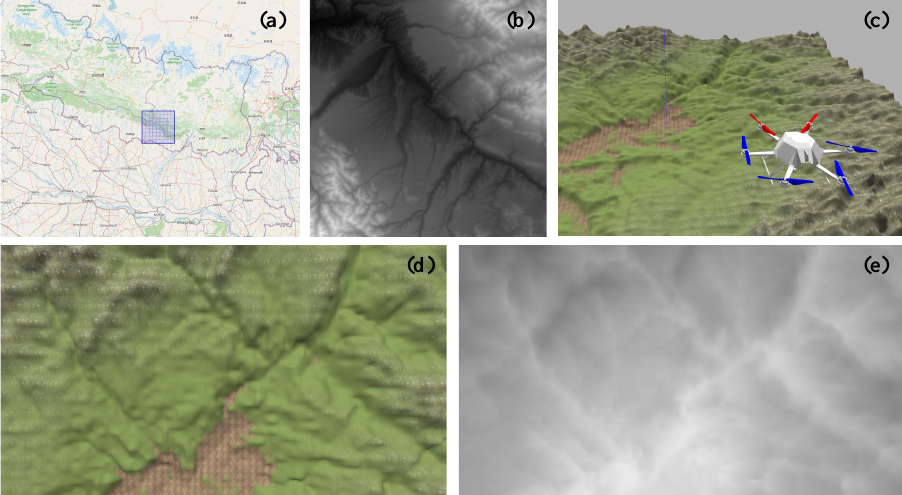
Figure 8. Selected area ( a ) is located in the middle part of the Himalayan, ( b ) is its corresponding depth maps generated by terrain.party. ( c ) shows the s UAV, which is equipped with an RGB-D camera for RGB video capture and depth ground truth data collection. The depth sampling distance of the camera is not limited. ( d ) is the example of registered color image for system input, and ( e ) is the ground truth depth map for accuracy evaluation.